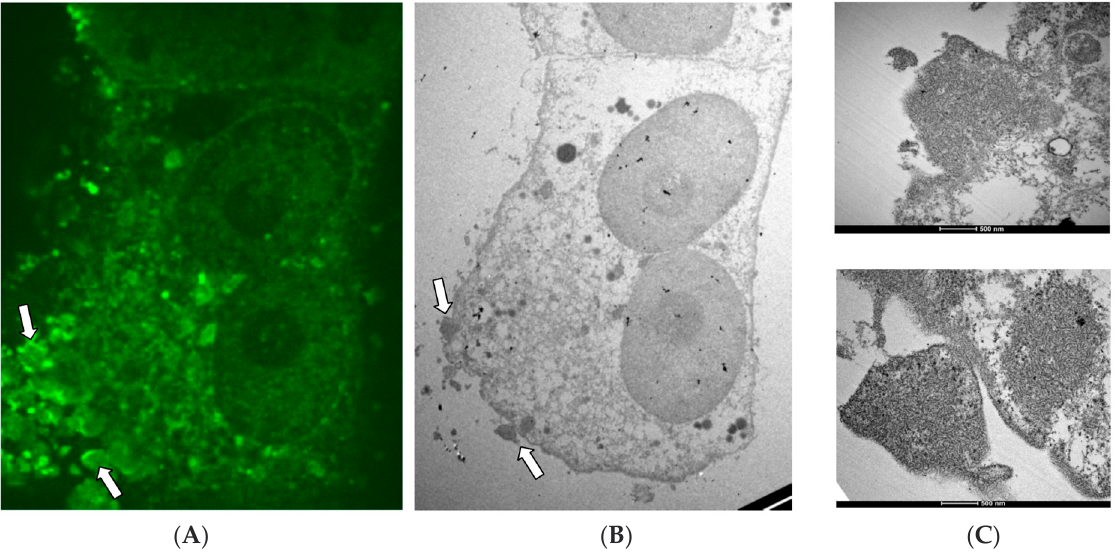
Figure 5. Detection of NiV N ordered structures with CLEM. NiV infected Vero cells were analyzed by fluorescence ( A ) and electron microscopy images ( B , C ) simultaneously. ( A ) NiV-infected cells, where NiV N is detected by spinning disc confocal microscopy. NiV ordered structures are indicated by white arrows. ( B ) The same syncytium as in image ( A ) is analyzed by electron microscopy. White arrows indicate NiV ordered structures. ( C ) The image on the right shows magnification of the NiV ordered clusters indicated with white arrows in images ( A , B ).